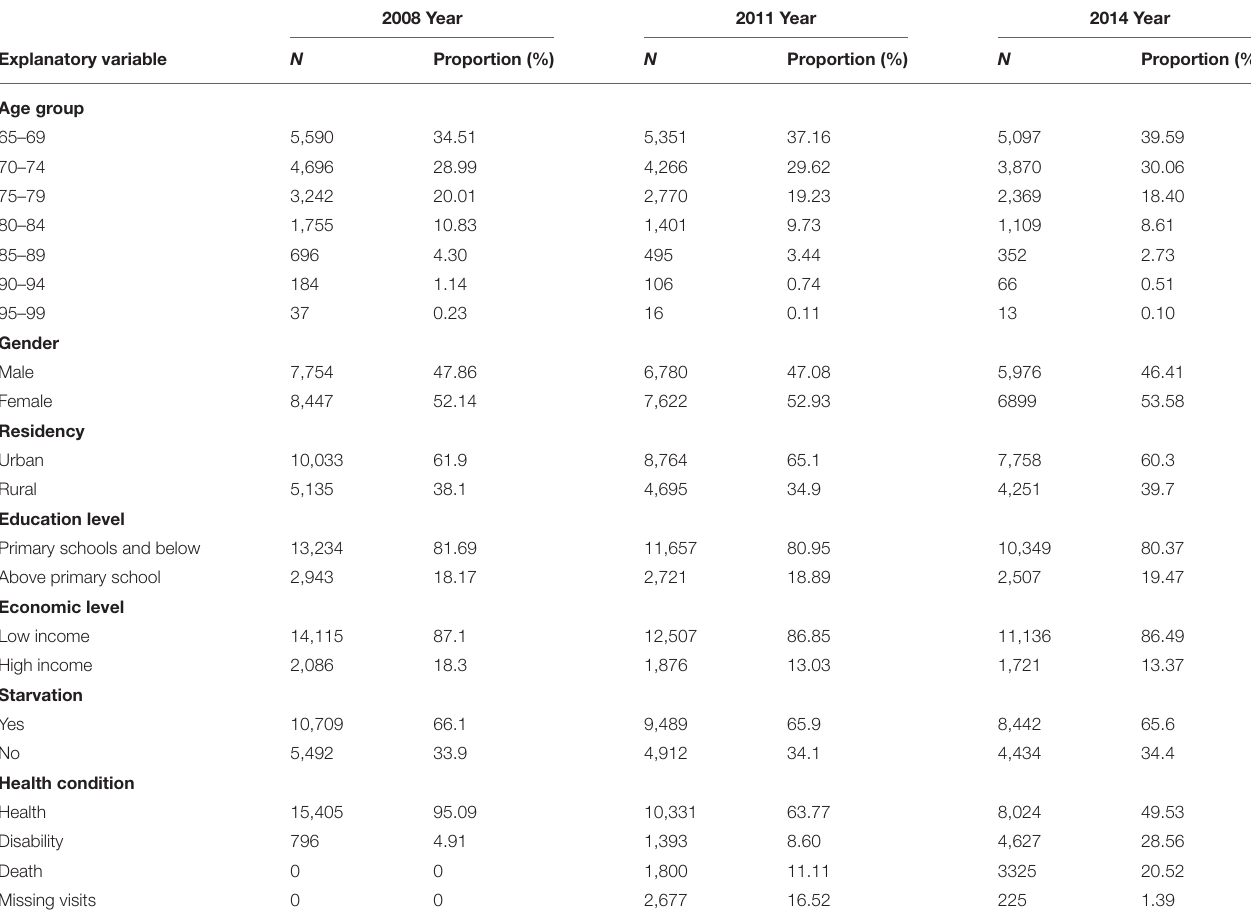
TABLE 1 | Basic situation and health transition of the